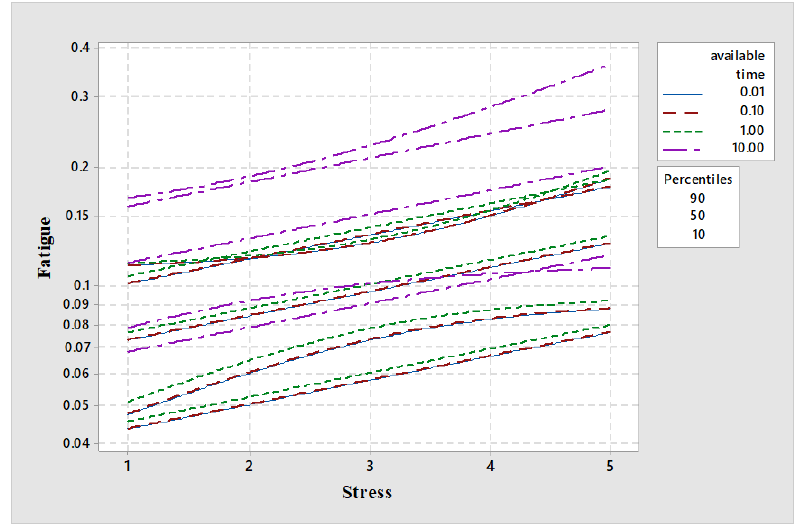
Fig. 3. The relation between fatigue and stress in different stress value.